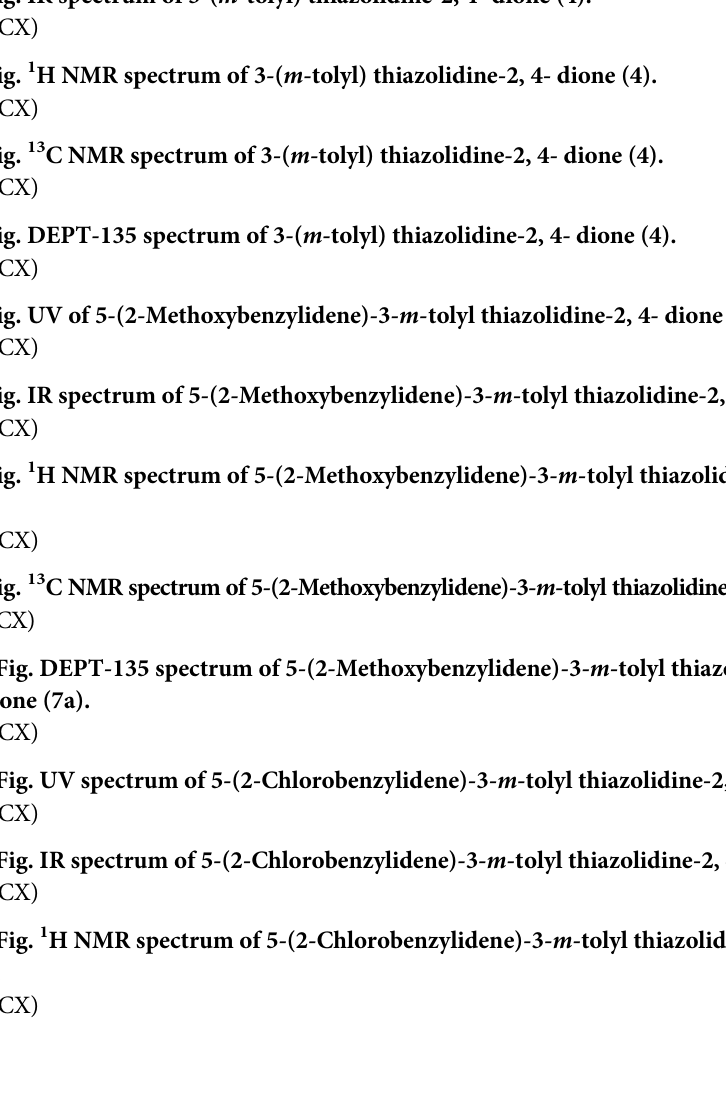
S1 Fig. UV spectrum of 3-( m -tolyl) thiazolidine-2, 4- dione (4).